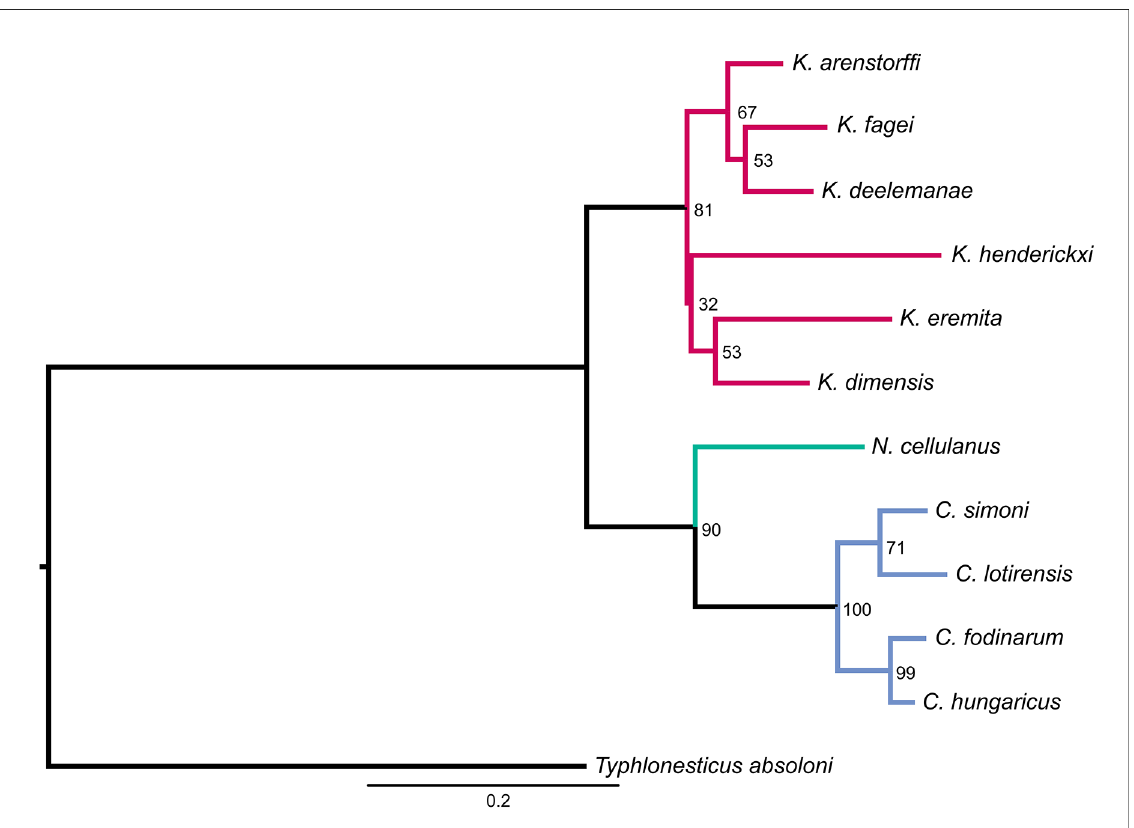
Fig 8. ML tree inferred from a concatenated matrix of cox1 and rrn mtDNA and H3 nuDNA gene fragments. Numbers next to nodes correspond to bootstrap support values. The tree was rooted using Typhlonesticus absoloni (Kratochvíl,